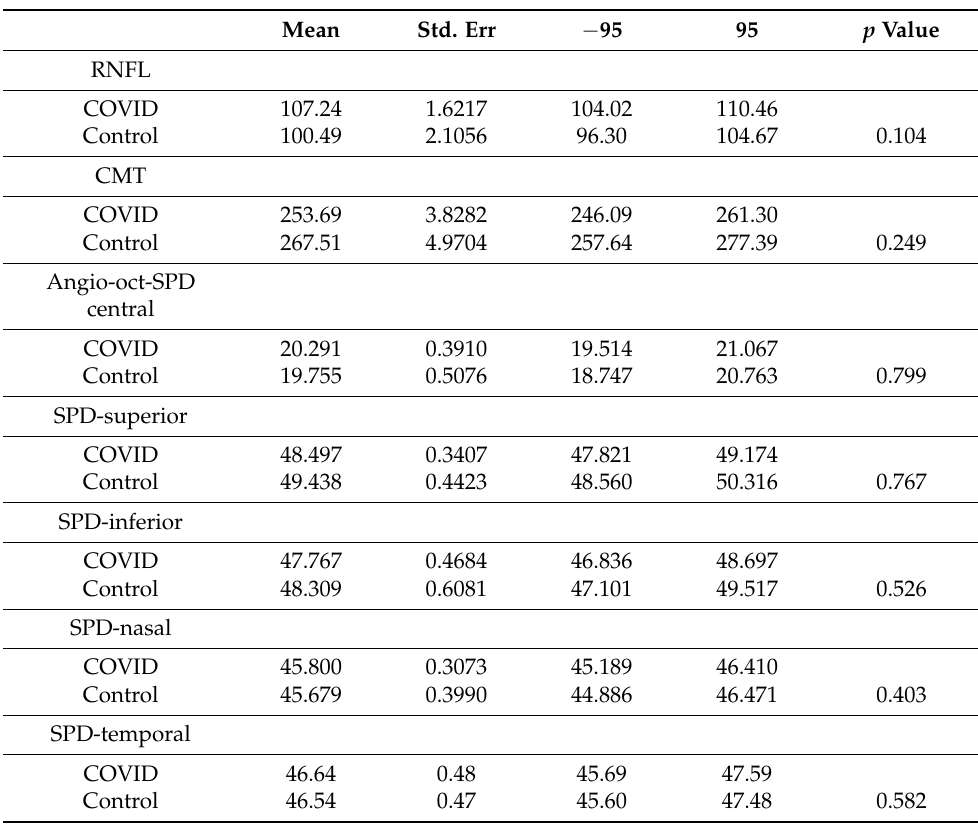
Table 2. Descriptive statistics for groups and t -test p